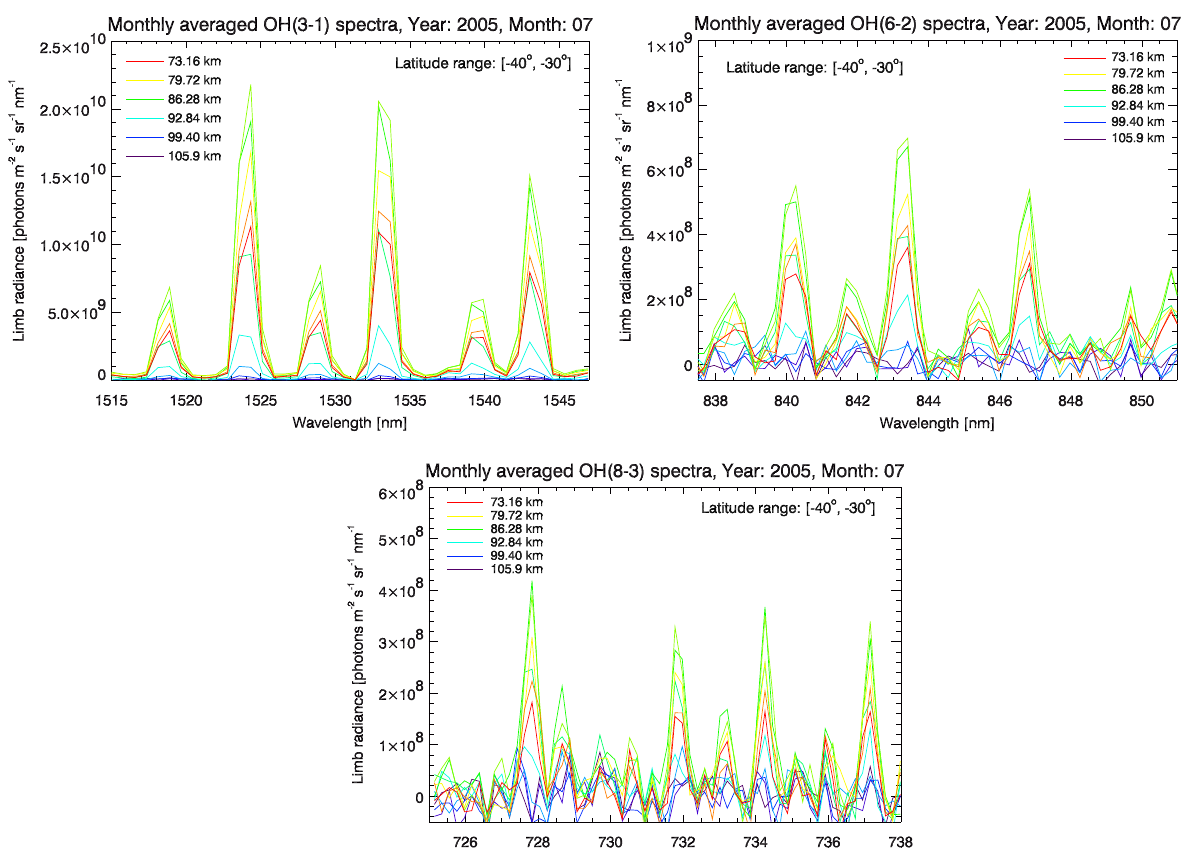
Fig. 1. Monthly and zonally averaged OH(3-1), OH(6-2) and OH(8-3) limb spectra for July 2005 and the 40 ◦ S–30 ◦ S latitude range. Note that the limb emission spectra at every second tangent height have been omitted for the sake of clarity.